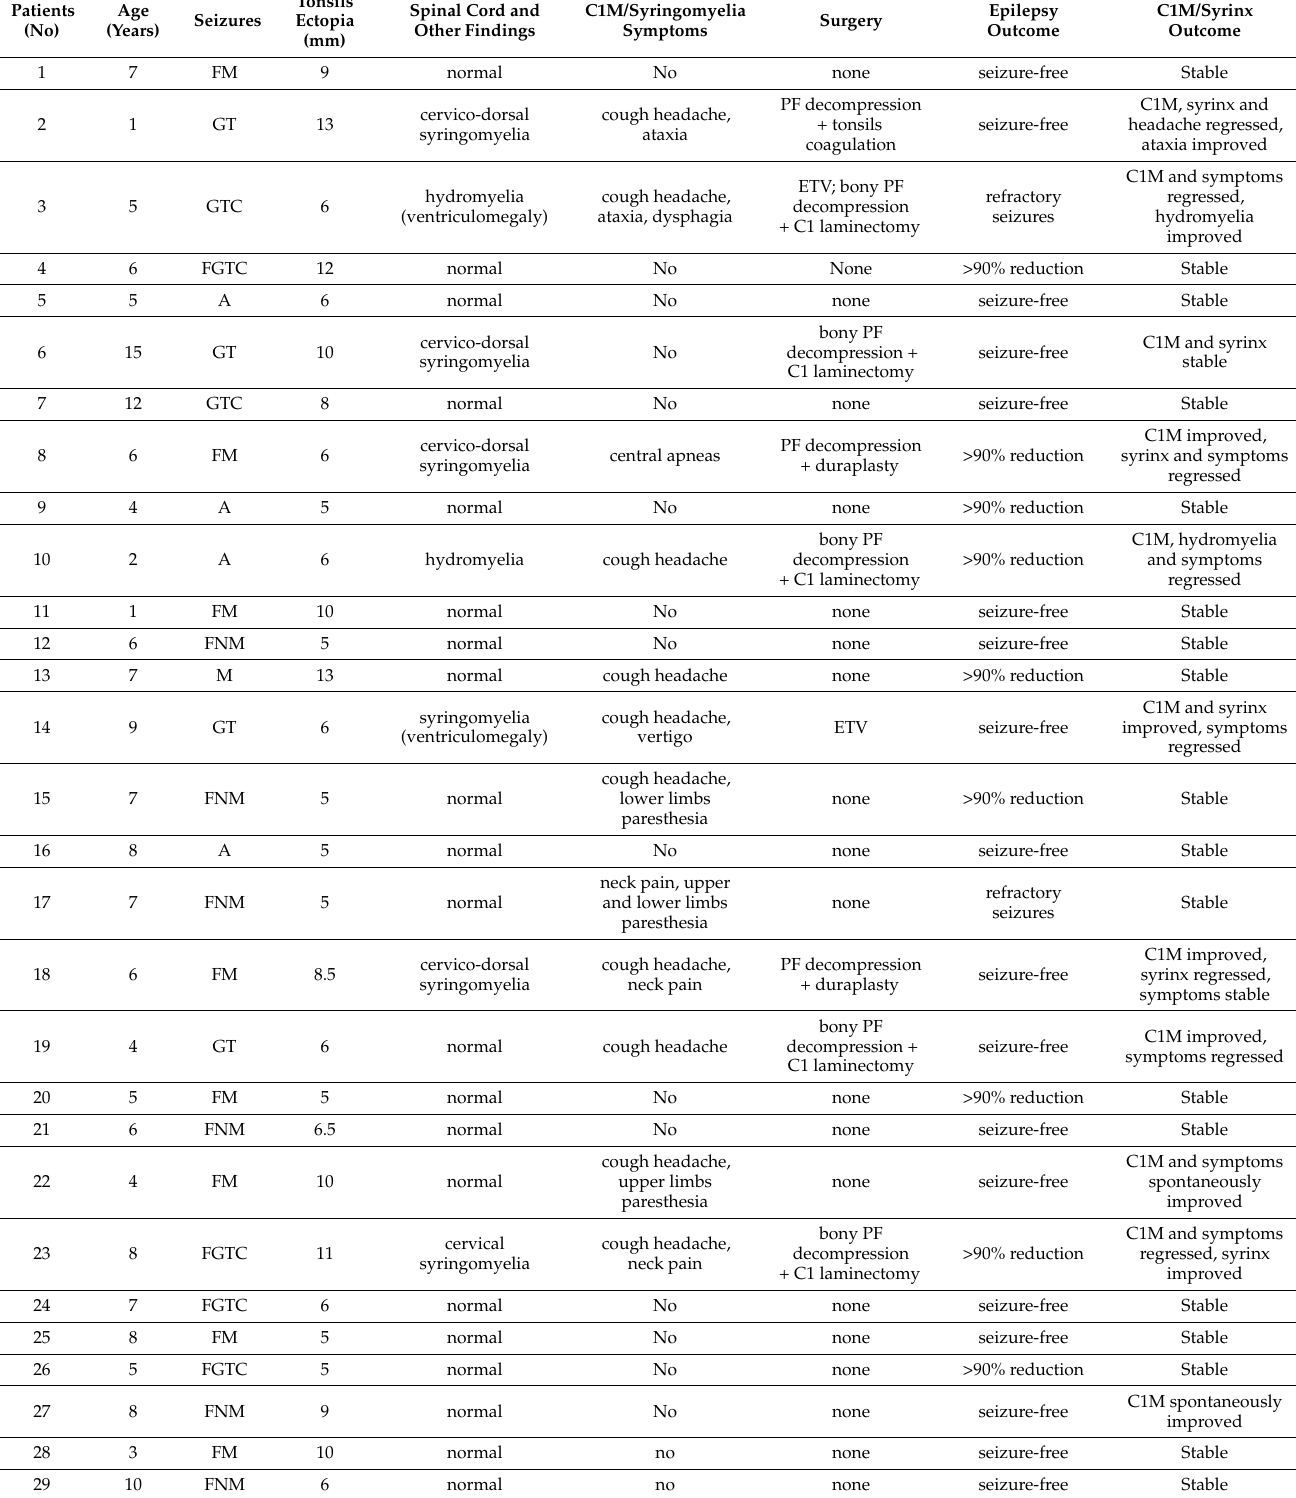
Table 3. Outcome of Group